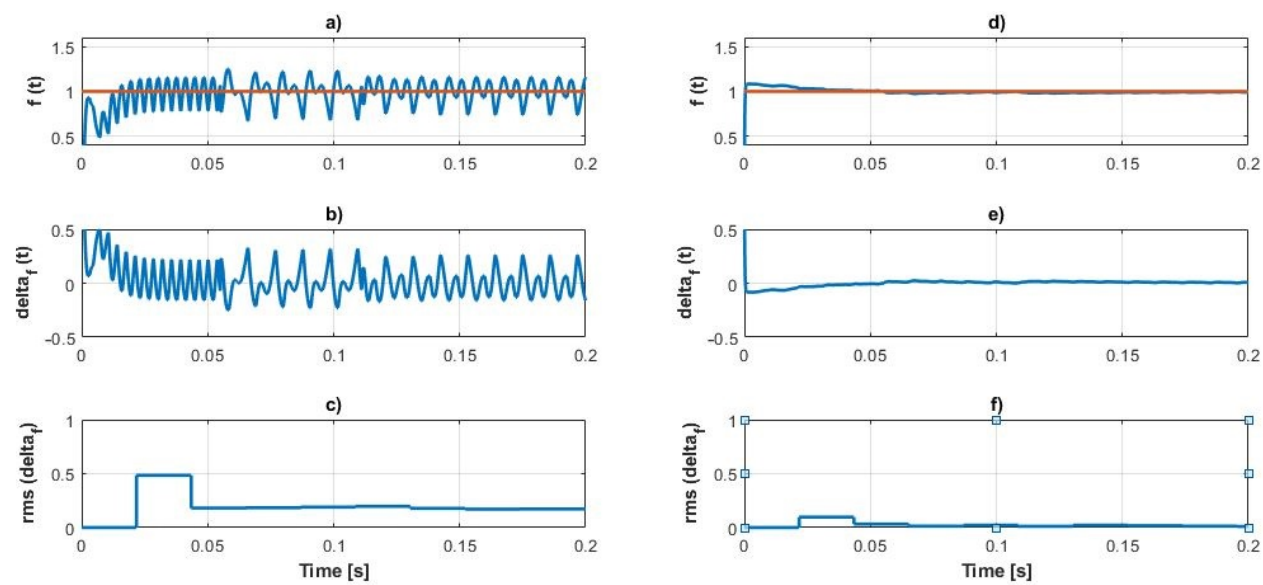
Figure 11. Frequency estimation in presence of harmonics for DDSRF-FLL ( a – c ) and DSOGI-FLL ( d – f ) where: ( a , d ) frequency estimated value (orange—reference, blue—tested algorithm), ( b , e ) frequency error between compared algorithms, and ( c , f ) RMS value-form frequency error.